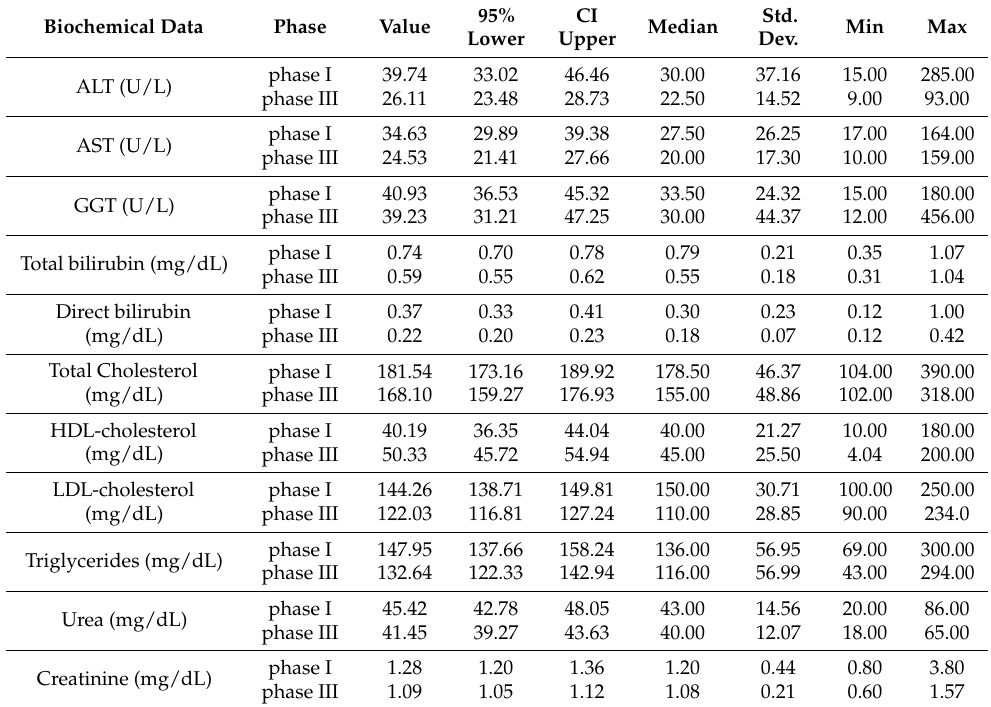
Table 3. Biochemical results in the two studied phases ( N =